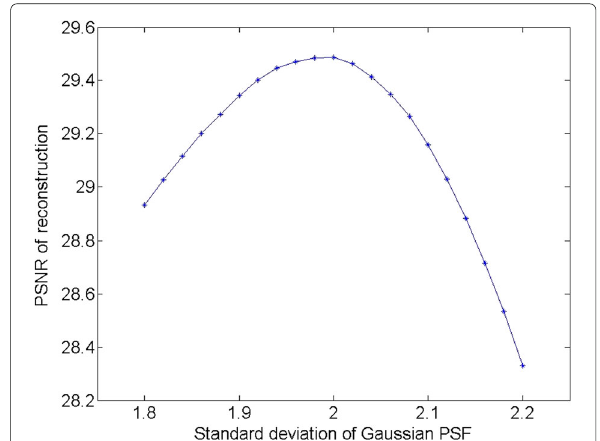
Fig. 4 PSNR of reconstruction with different